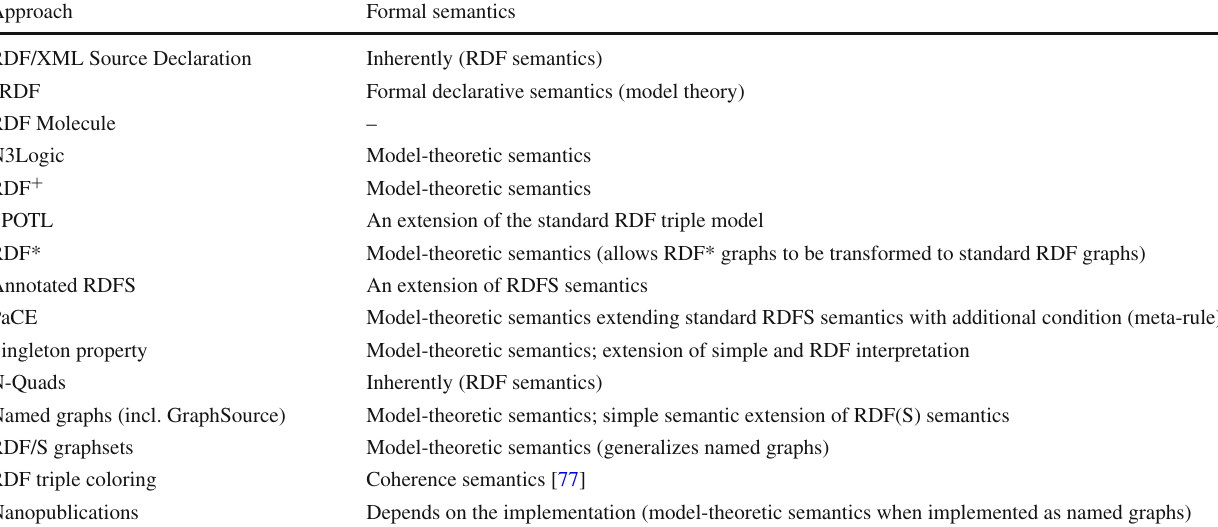
Table 3 Formal semantics of reification